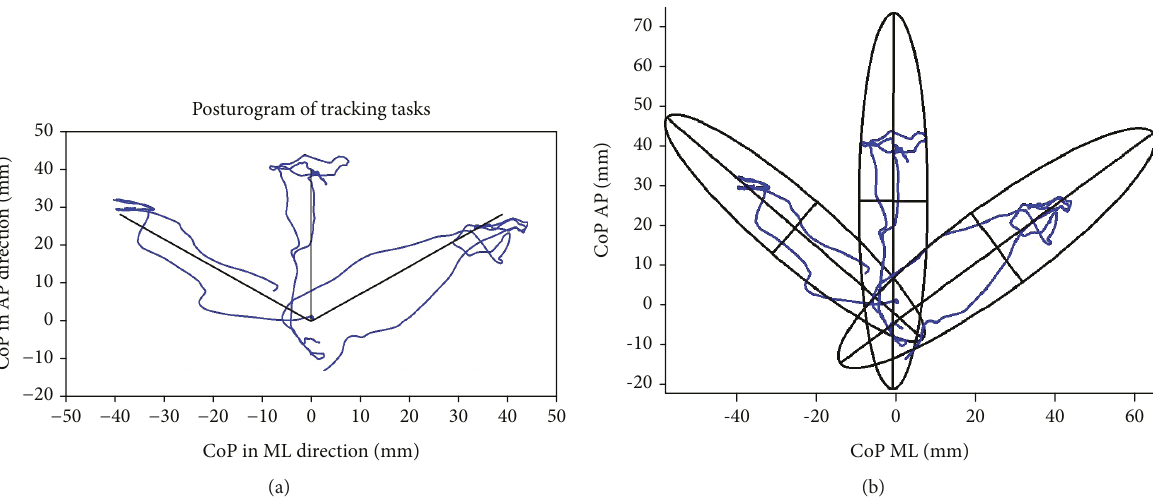
Figure 7: (a) Typical posturogram and (b) 95% prediction ellipses for CoP-tracking tasks in the forward and diagonal directions. The 95% PEA for the leaning movements in the forward direction was 1276.5mm 2 , 1141.8mm 2 in the forward-right direction, and 1645.2mm 2 in the forward-left direction. Based on the orientation of the laboratory coordinate system, postural adjustments in the forward direction are indicated as CoP increasing from the nominal starting position. Postural shifts towards the left are indicated as CoP AP the nominal.